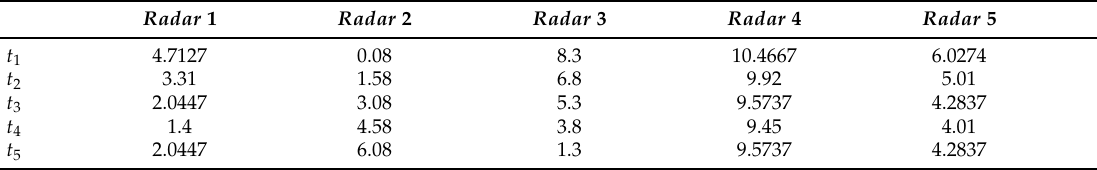
Table 3. Distances between five radars and target at five moments when the target moves along a straight line.